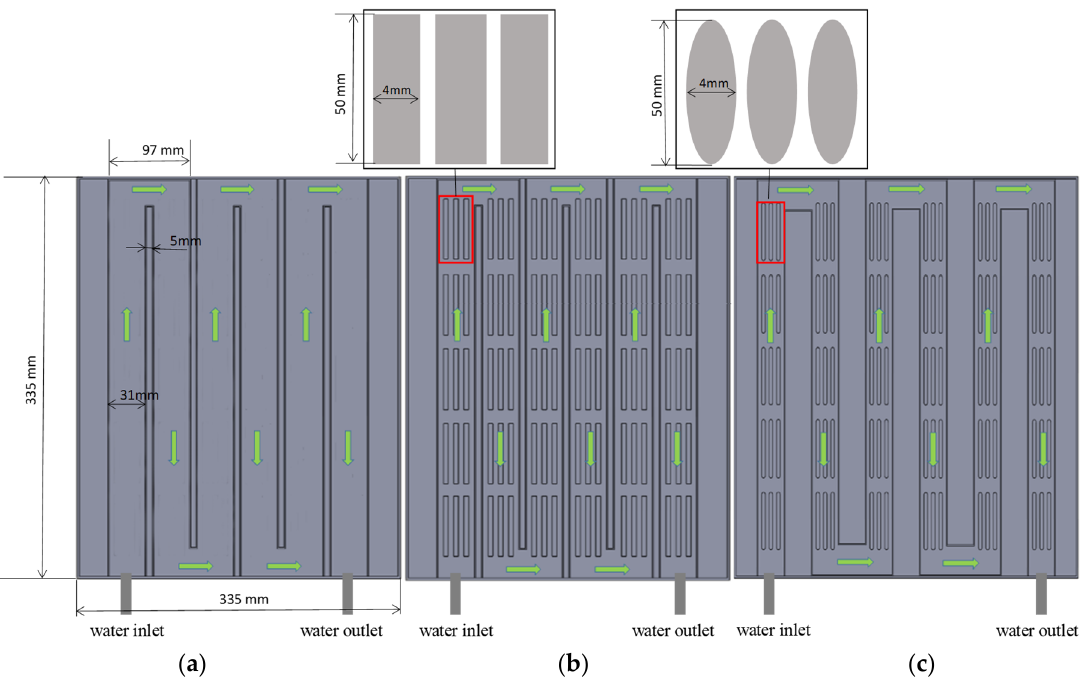
Figure 2. The internal structure of three types of water ‐ cooled plates. ( a ) No spoiler column. ( b ) Rectangular spoiler. ( c ) Elliptical spoiler.